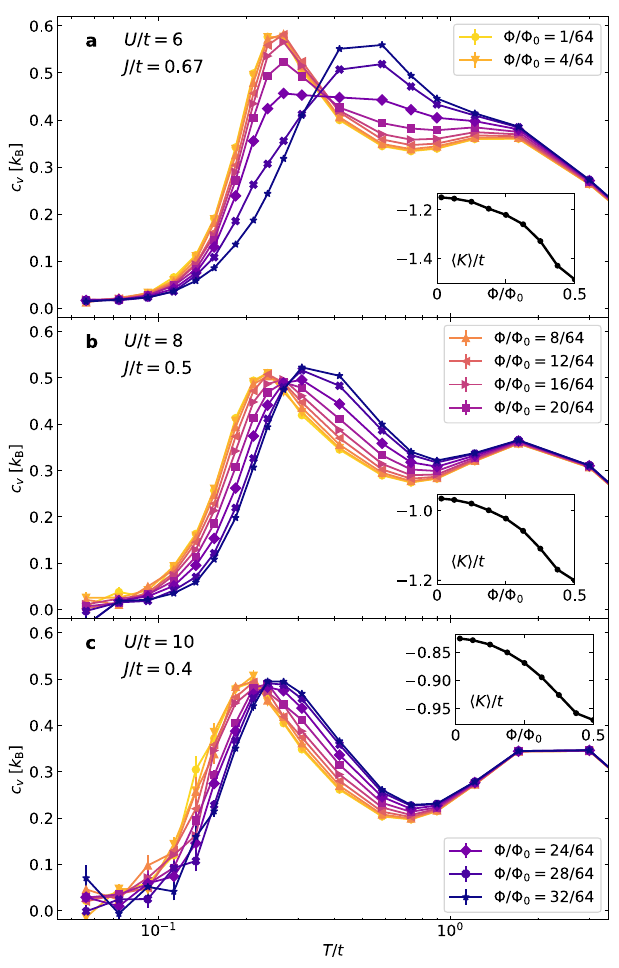
Fig. 5 Evolution of speci fi c heat and kinetic energy in the half- fi lled Hubbard – Hofstadter model. Temperature and fi eld dependence of speci fi c heat c v at half fi lling. Insets display the fi eld dependence of kinetic energy 〈 K 〉 at β t = 16 for magnetic fi eld strength Φ / Φ ∈ [0, 0.5]. a - c Correspond 0 to Hubbard interaction strength U / t = 6 – 10, respectively. Values of J = 4 t 2 / U are also indicated for each U . Curves with the same color and marker type have the same magnetic fi eld strength across all panels. Error bars denote ±1 standard error of the mean, estimated by jackknife